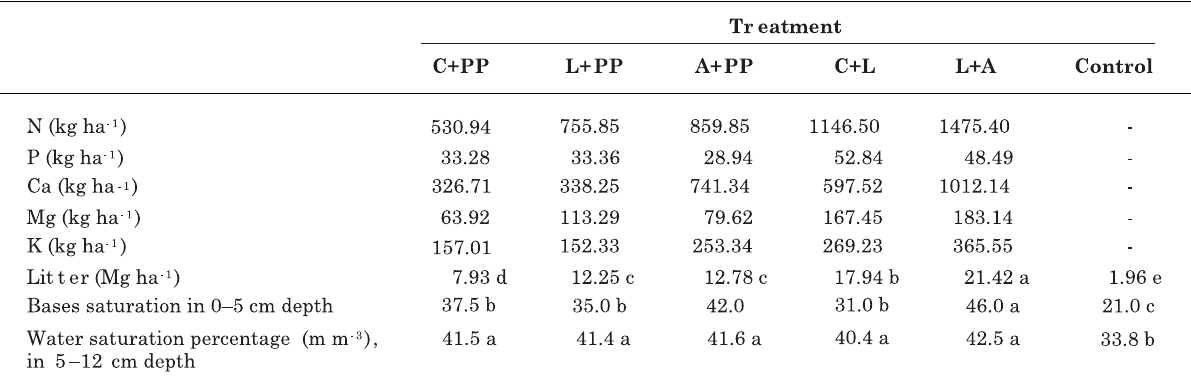
Means in a row followed by same letter are not significantly different at 5 % in the Tukey